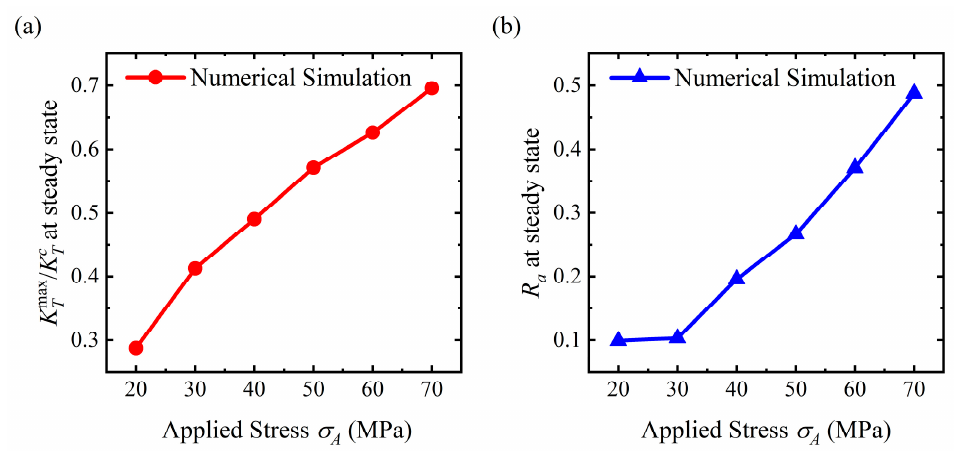
Figure 15. ( a ) Maximal stress concentration factor and ( b ) surface roughness under a steady state for different applied stresses when A ∗ =